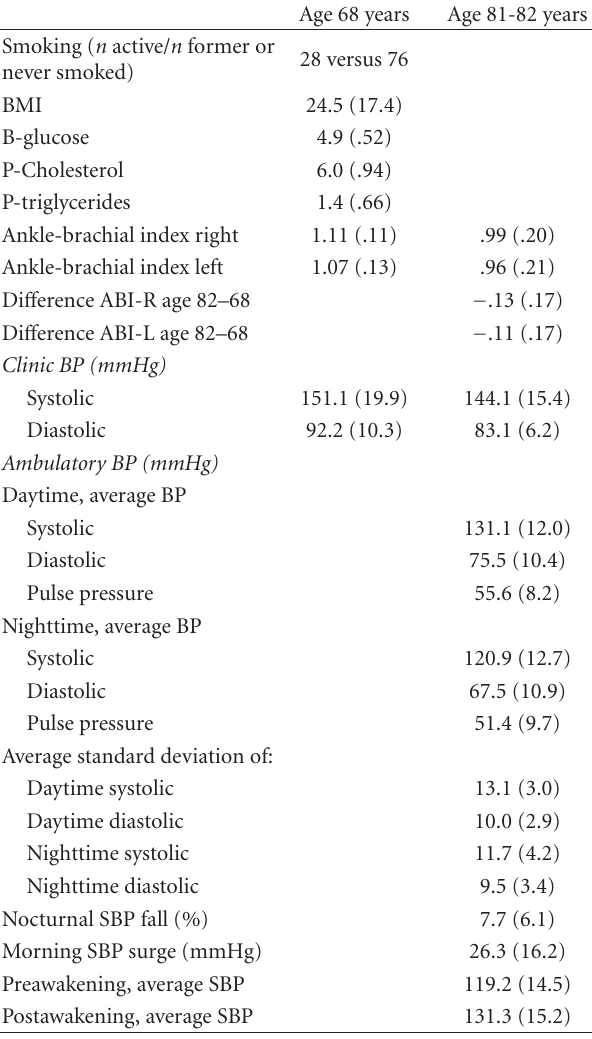
Table 1: The background data from the 1st and the 2nd followup of the cohort “Men born